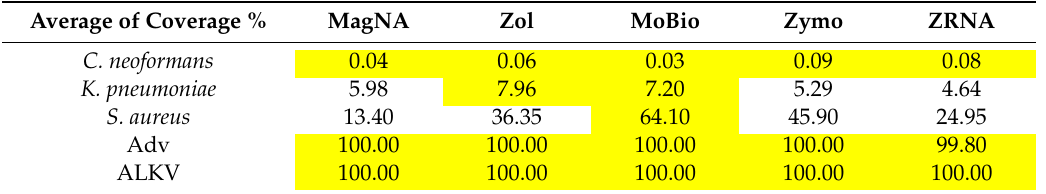
Table 3. Average coverage percentage (coverage %) from RNA sequencing for the pathogens included in the mock sample using di ff erent